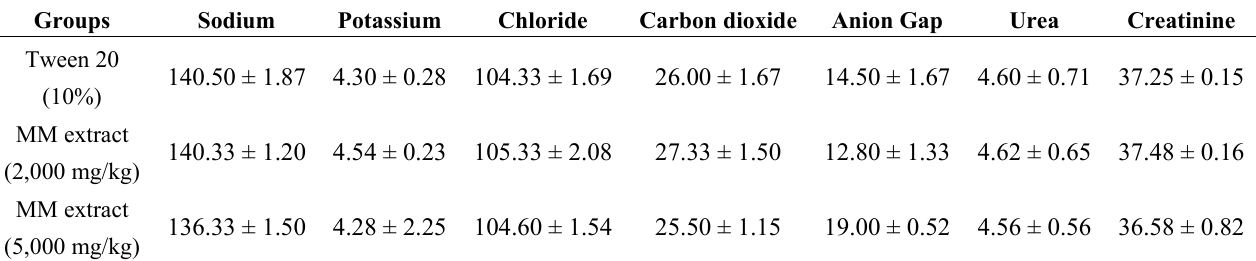
Table 5. Effects 2,000 mg/kg and 5,000 mg/kg of MM extract on kidney biochemical